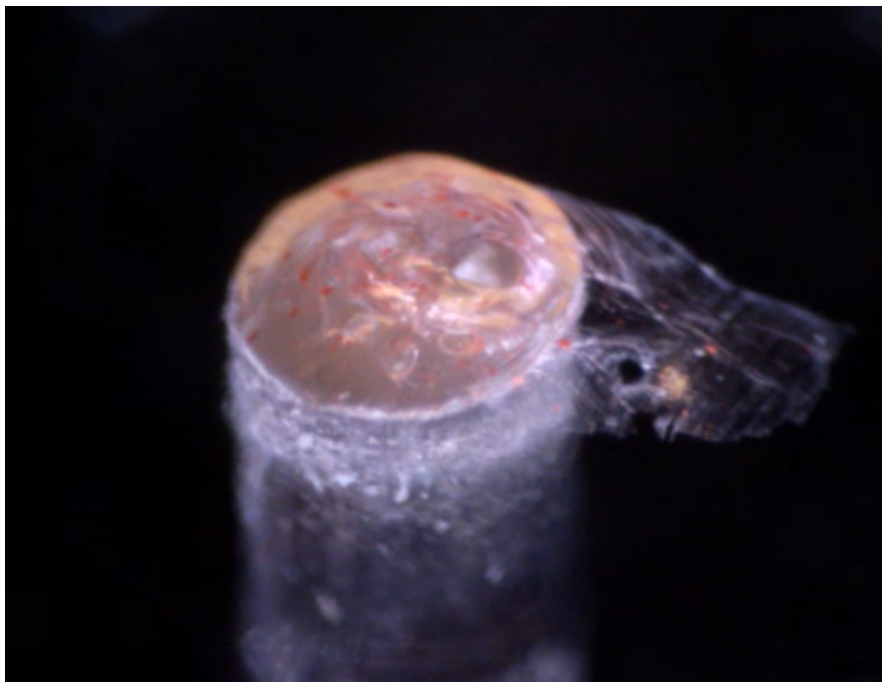
Figure 7. A fiber sensor which has been manufactured with a “bad” solvent. Clumps are visible due to a poor dispersion of the photoluminescent compound (PtOEP in this case). In this particular sensor, the solvent used was